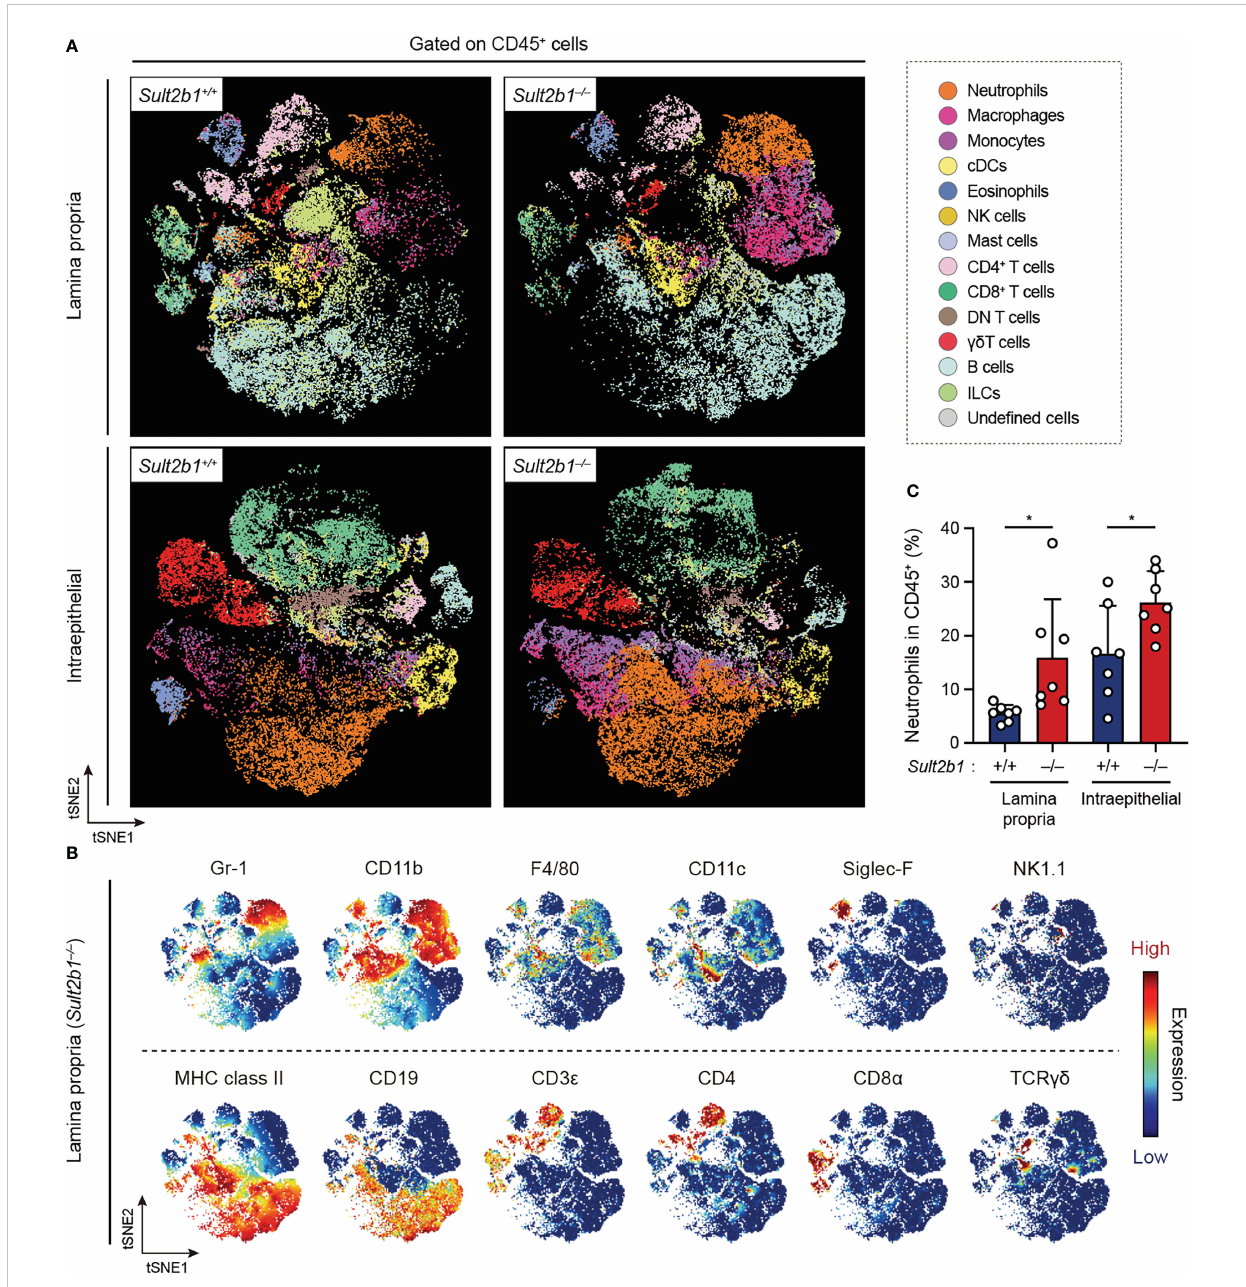
FIGURE 4 CS de fi ciency alters the composition of immune cells during gut in fl ammation. (A) FlowSOM analyses of intraepithelial and lamina propria immune cells isolated from the colon of Sult2b1 +/ − and Sult2b1 − / − mice on day 7 after a 5-day 1.5% DSS challenge. After gating on singlets, live CD45 + cells were concatenated from 7 mice per group and clustered using the viSNE. Distinct metaclusters are shown in different colors. (B) t-SNE plots overlaid with the expression heatmaps of individual markers (red and blue indicate high and low expression, respectively). (C) Percentage of neutrophils (CD45 + CD3 e − CD19 − Gr-1 + CD11b + ) to the total intraepithelial and lamina propria CD45 + cells (n = 7 mice per group; two-tailed unpaired Student ’ s t -test). Data were obtained from three independent experiments (A-C) , and graphs are shown as the mean ± SD. * P <